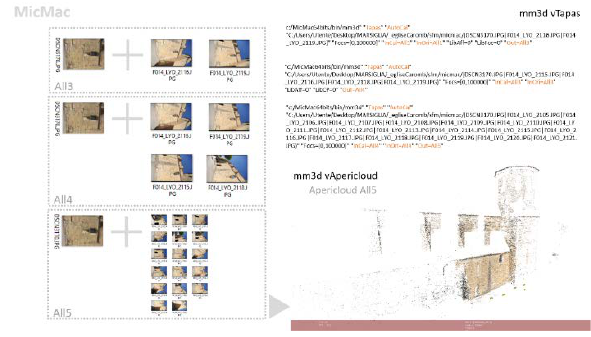
Figure 4. Orientation phase.